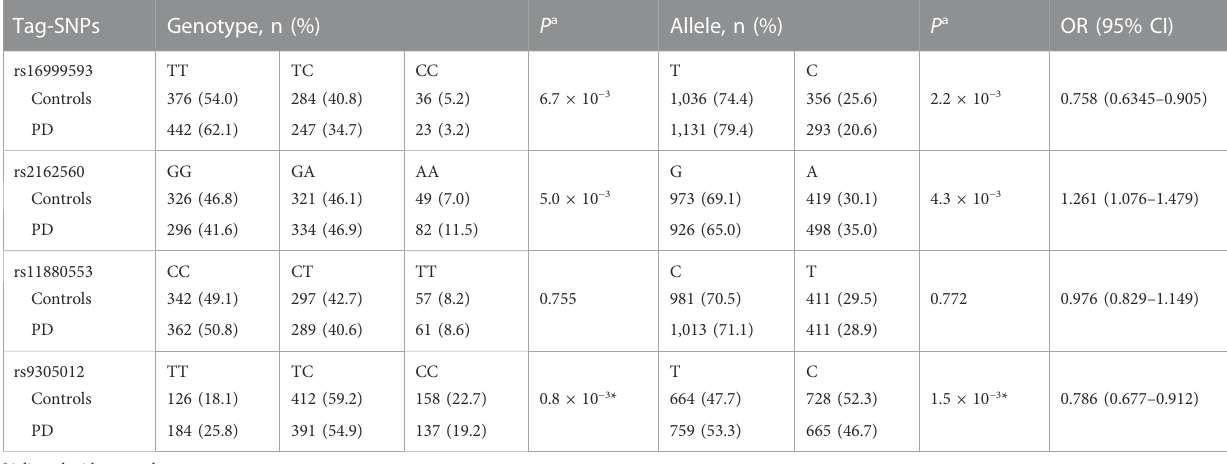
TABLE 2 Genotype and allele frequencies of DNMT1 tag-SNPs in PD patients and controls. Tag-SNPs